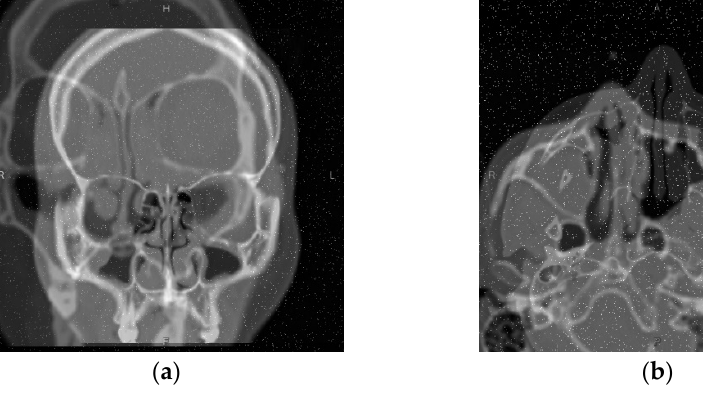
Figure 13. ( a,b ) are the mixup method’s result.